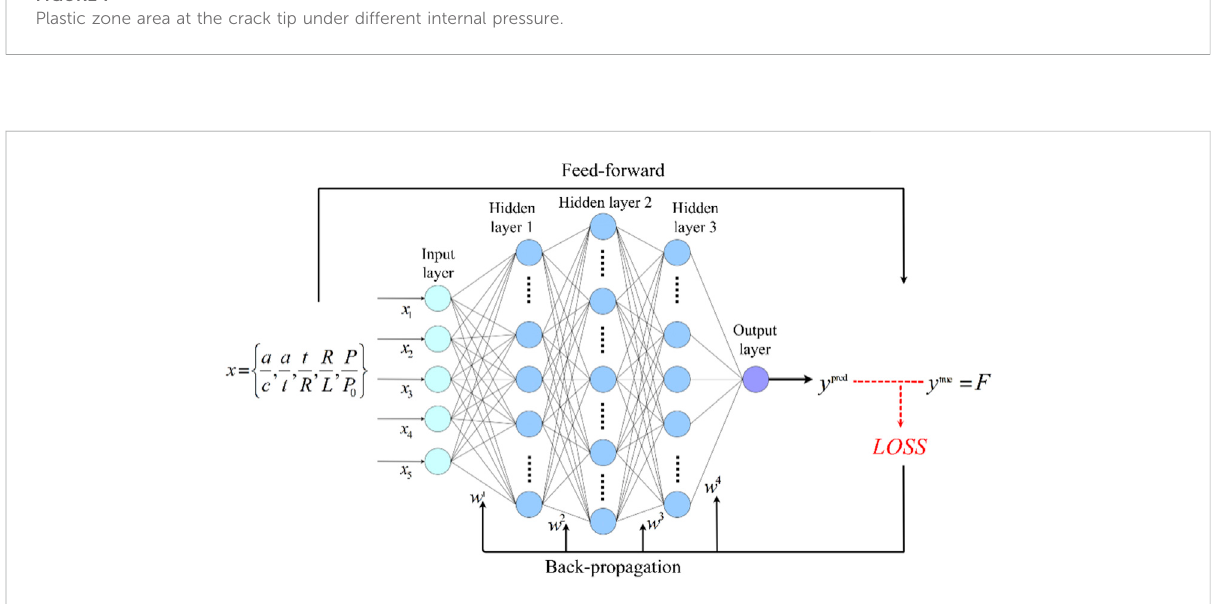
FIGURE 8 BPNN with 3 hidden